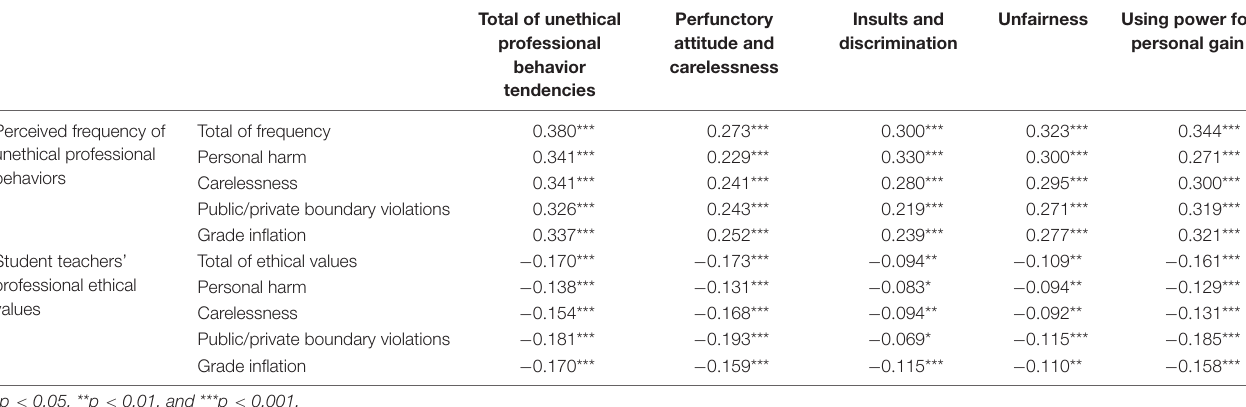
TABLE 8 | Correlations between student teachers’ unethical professional behavior tendencies, professional ethical values, and perceived frequency of unethical professional behaviors (analysis based on a total sample).